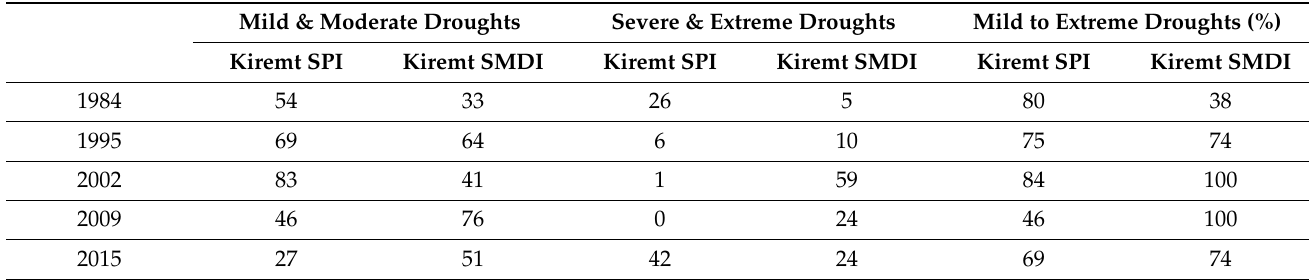
agricultural drought in the selected drought years. Table 3 shows the percentage of the area affected by meteorological and agricultural droughts at annual time scale. In 1984, 40% of the area was struck by severe to extreme meteorological drought and followed by 2015 where 36% of the area was affected by the same drought categories. However, large parts of the basin (54%) were affected by agricultural drought in 2002. Mild to moderate meteorological and agricultural droughts were dominated in 1995 as compared to the other drought years. Table 2. Percentages of area under drought condition during the selected historic drought episodes for Kiremt season. Mild & Moderate Droughts Severe & Extreme Droughts Mild to Extreme Droughts (%) Kiremt SPI